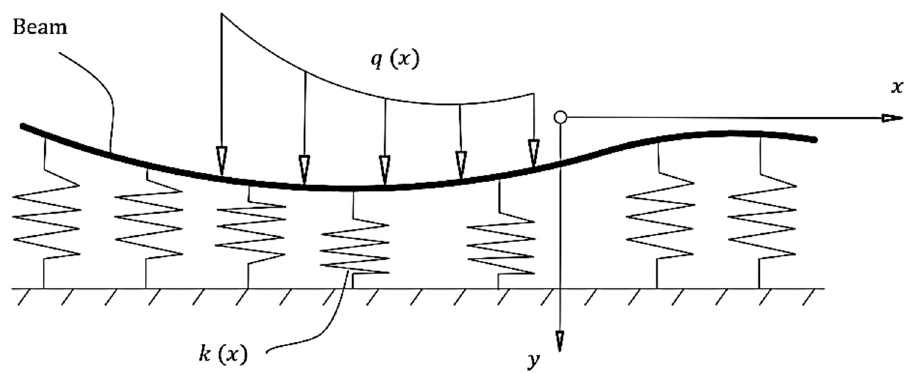
Figure 1. A free–free beam resting on Winkler foundation.